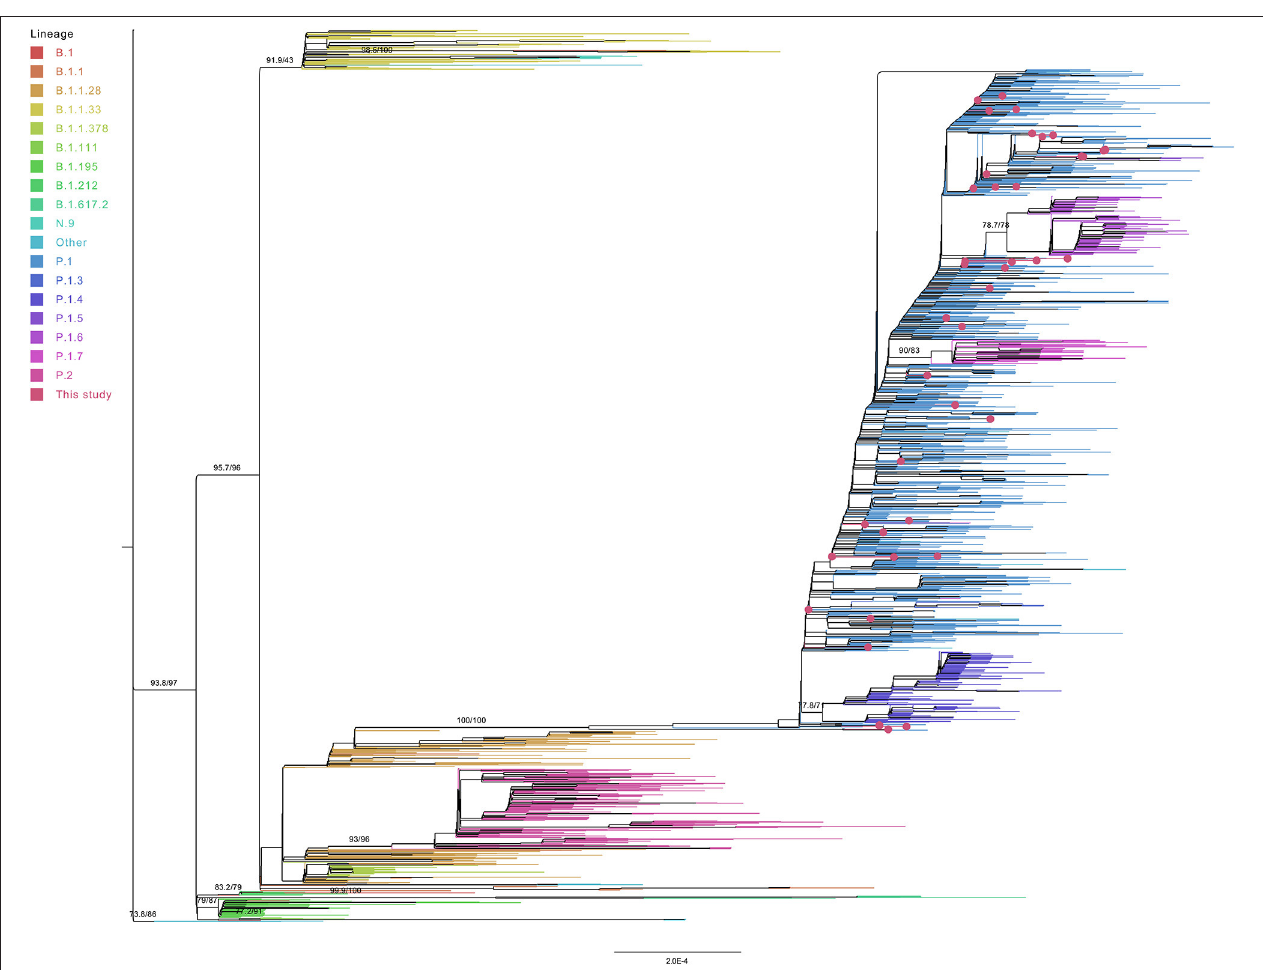
FIGURE 4 | Maximum Likelihood tree of 1,887 unique genomes from the North region—Brazil, added to the 44 sequenced samples of this study. Pangolin lineages represented by < five genomes are labeled as “Other.”